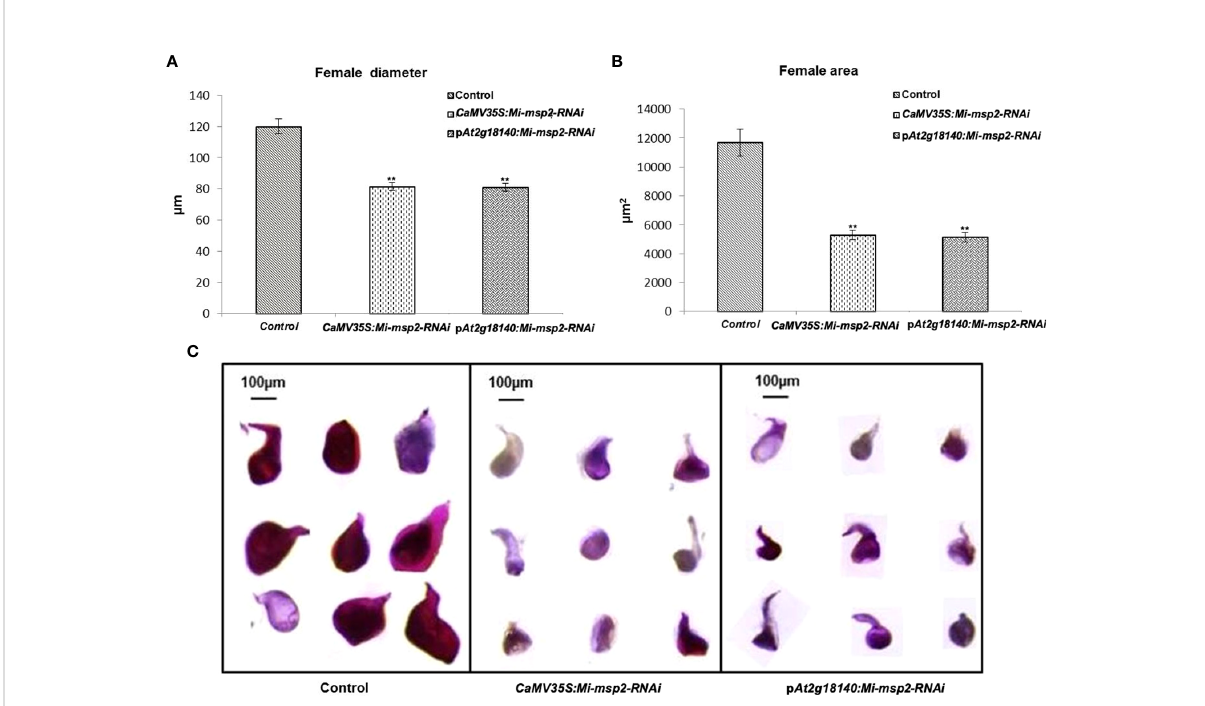
FIGURE 6 Morphological size comparison of female nematodes isolated from the control and RNAi plant lines CaMV35S::Mi-msp2-RNAi and p At2g18140:: Mi-msp2-RNA i (cumulative females from all fi ve lines of each of the RNAi constructs). (A) Average female width ( m m), (B) average female area ( m m 2 ). Each bar represents the mean±SE. Double asterisks indicate statistically signi fi cant differences according to one-way ANOVA and Tukey ’ s test (p ≤ 0.01). Representative images of adult females isolated from (C) Control, CaMV35S::Mi-msp2-RNAi and pAt2g18140::Mi-msp2-RNAi RNAi